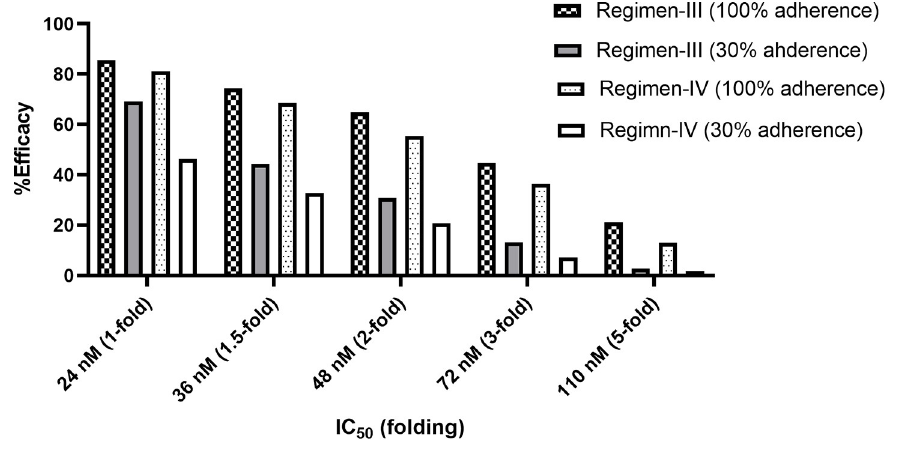
Fig 5. Comparisons of treatment efficacy of two propose regimens (III, and IV) between 100% of adherence and 30% of adherence in patients with resistant mefloquine.